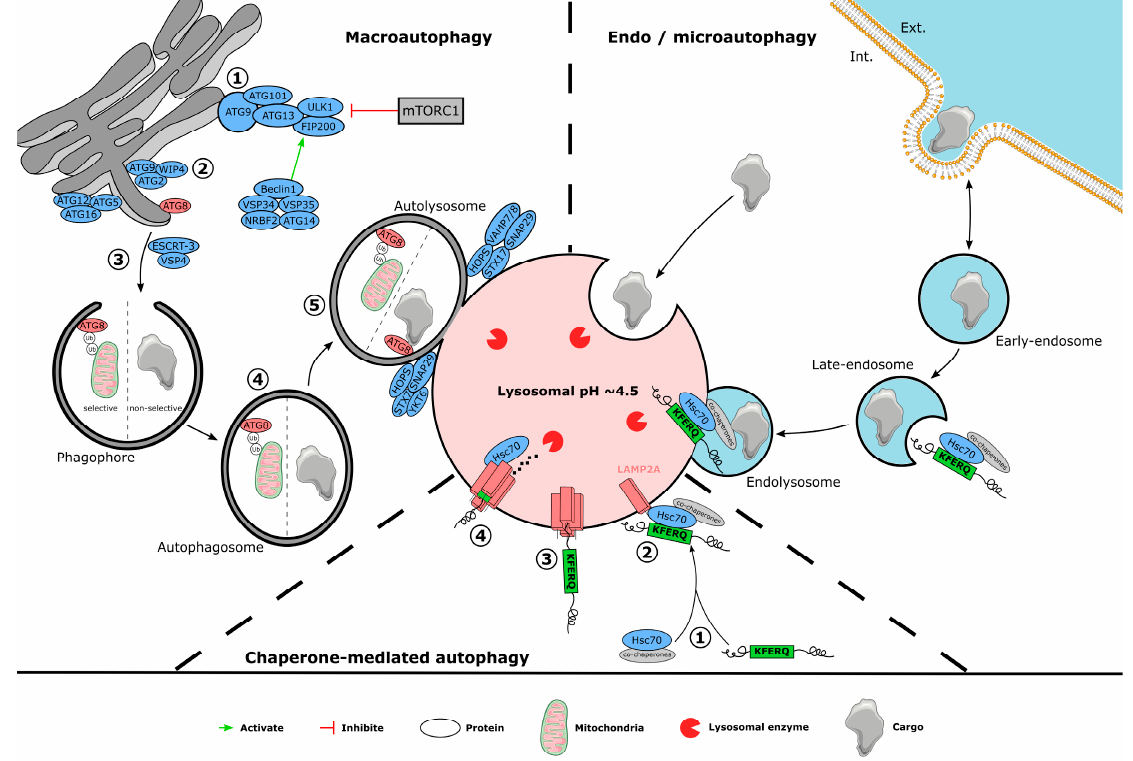
Figure 1. Schematic representation of different autophagic pathways . Macroautophagy is com- posed of (1) the initiation phase, (2) the elongation phase, (3) the separation and enclosure of the phagophore, (4) the maturation step, and (5) the fusion with the lysosome. Chaperone-mediated au- tophagy starts with (1) the recognition of the KFERQ motif by the Hsc70 complex, (2) leading the cargo to LAMP2A, which (3) translocates, unfolds, and (4) degrades the protein. Endo/microautophagy is characterized by cargo capture directly by the endosome or lysosome before lysosomal